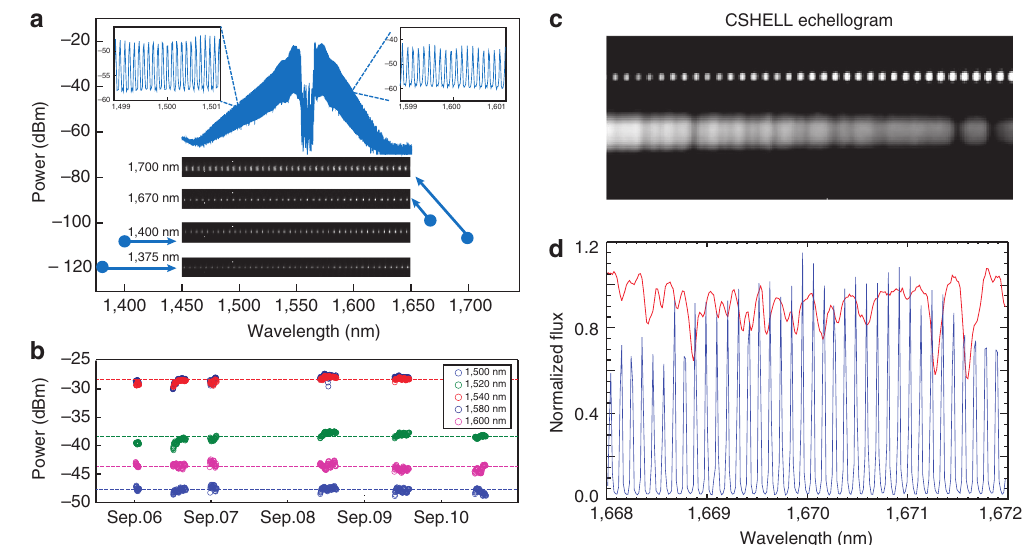
Figure 4 | Experimental results at IRTF. ( a ) Comb spectrum produced using 1,559.9nm reference laser. The insets on top left and right show the resolved comb lines on the optical spectrum analyser. Comb spectra taken by the CSHELL spectrograph at 1,375, 1,400, 1,670 and 1,700nm are presented as insets in the lower half of the figure. The blue circles mark the estimated comb line power and centre wavelength for these spectra. Comb lines are detectable on CSHELL at fW power levels. ( b ) Comb spectral line power versus time is shown at five different wavelengths. During the 5 day test at IRTF, no parameter adjustment was made, and comb intensity was very stable even with multiple power-on and -off cycling of the optical continuum generation system. ( c ) An image of the echelle spectrum from CSHELL on IRTF showing a 4nm portion of spectrum B 1,670nm. The top row of dots are the laser comb lines, while the broad spectrum at the bottom is from the bright M2 II–III giant star b Peg seen through dense cloud cover. ( d ) Spectra extracted from c . The solid red curve denotes the average of 11 individual spectra of b Peg (without the gas cell) obtained with CSHELL on the IRTF. The regular sine-wave like blue lines show the spectrum from the laser comb obtained simultaneously with the stellar spectrum. The vertical axis is normalized flux